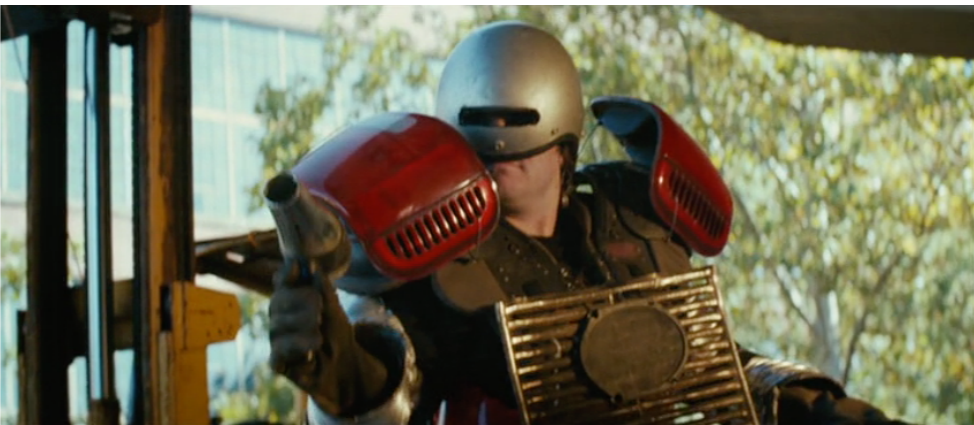
Figure 4. Jerry (Jack Black) as Robo